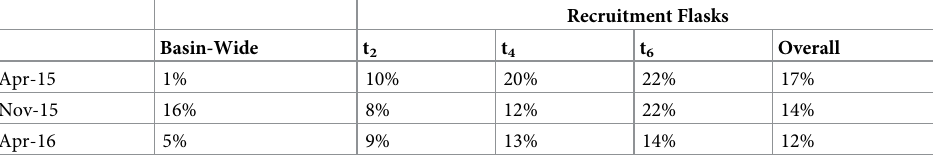
Table 6. Average percentage of total Microcystis population that was potentially-toxic in both the sediments and the recruitment